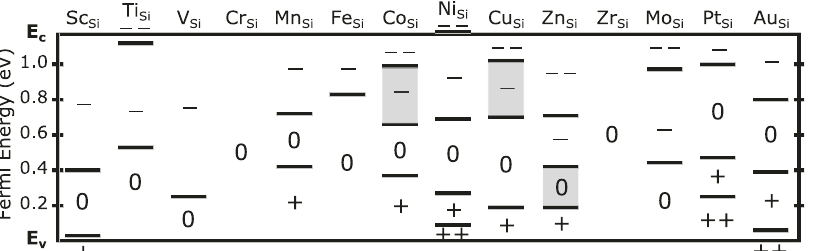
Fig. 2 Thermodynamics charge transition levels for substitutional defects of transition metals. Semi-transparent gray areas highlight the Fermi energy range for the fi nal candidates with triplet – triplet optical transitions within the Si band gap to be stable. 0, + , and − signs indicate the dominant charge state within the Fermi energy